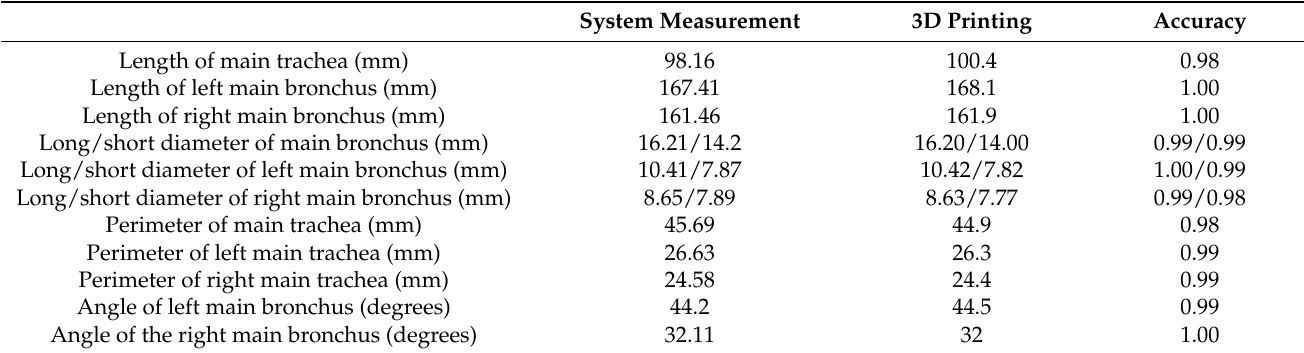
Figure 18. Measurement method (the redline is the length of the left main trachea, while the green line is the length of the right main trachea). Table 3. 3D printing